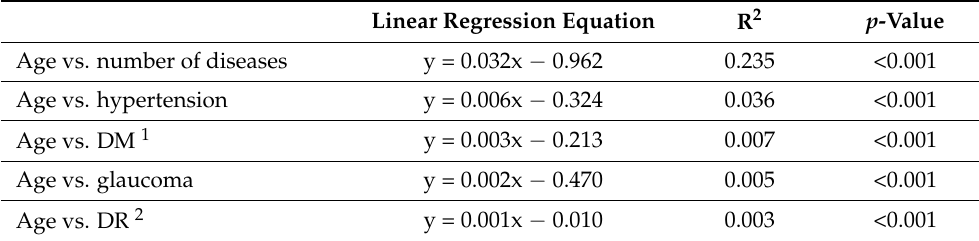
Table 3. Linear regression equation between age and number of diseases.